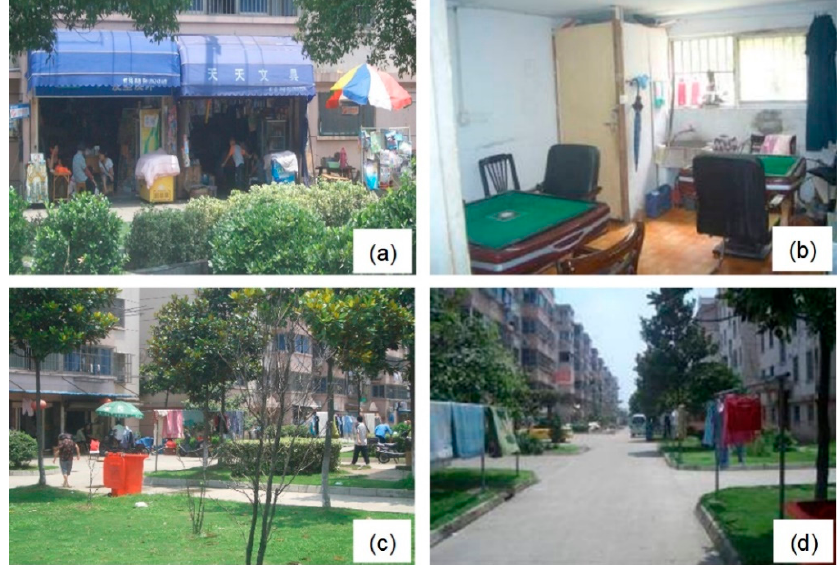
Figure 8. Communication space of Qunyi Community. ( a ) Grocery, ( b ) mahjong and chess room, ( c ) entryway of each building, ( d ) road in front of the apartment building.